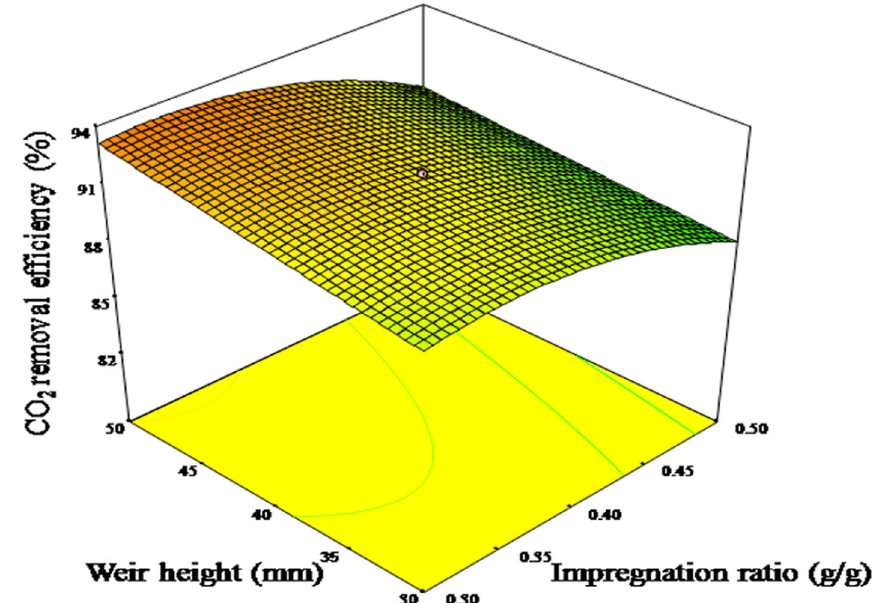
Fig. 9 Combined effect of weir height and impregnation ratio on CO 2 removal efficiency (%) at CO 2 concentration 11,500 ppm